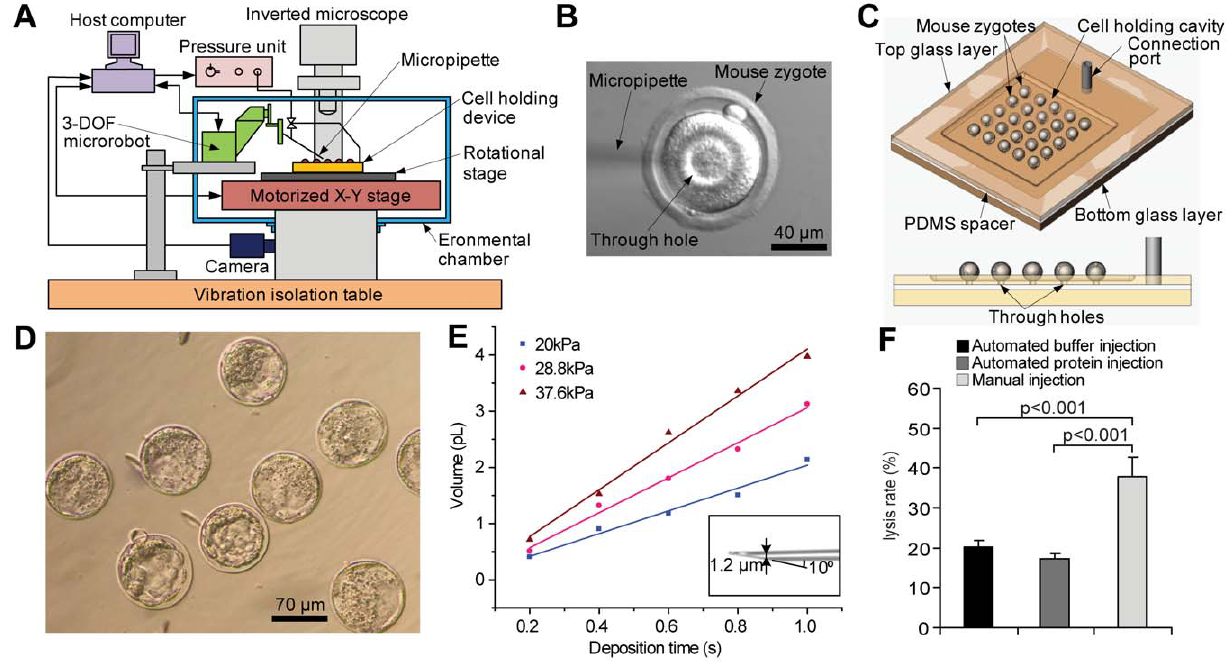
Figure 1. Automated robotic microinjection of mouse zygotes. (A) The robotic system employs a glass micro device to immobilize a large number of mouse zygotes into a regular pattern via fine vacuum and micrometer-sized through holes underneath cells. Based on precise position control and microscopy vision feedback, a three-degrees-of-freedom (3-DOF) micromanipulator, a motorized X-Y stage, and an in-house developed rotational stage are automatically controlled by a host computer to control an injection micropipette and position/orient the zygotes,